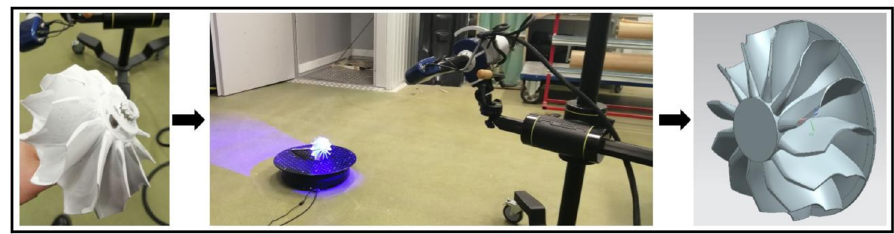
Figure 1. The scanning process of the K44 turbine wheel.